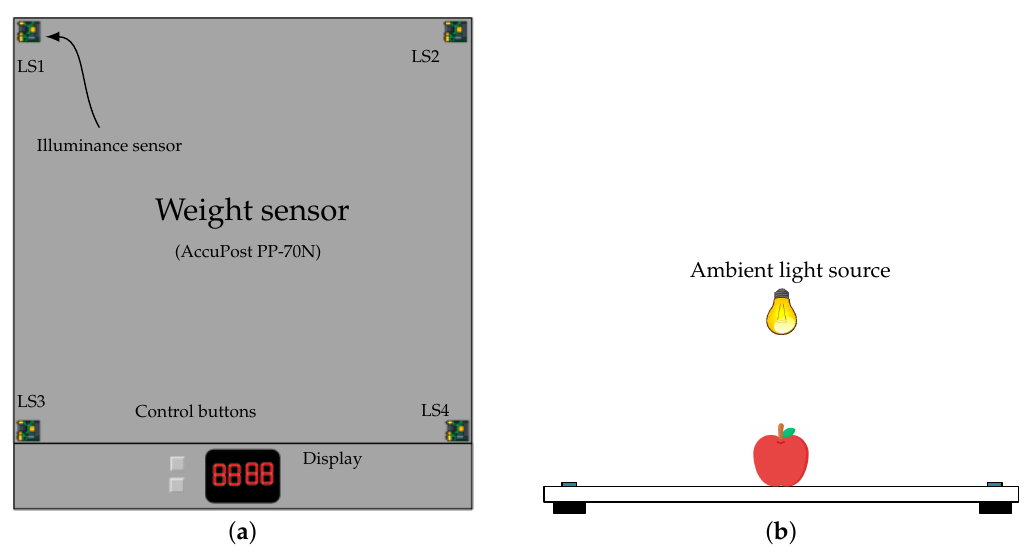
Figure 1. The detailed layout of: ( a ) Relative placement of weight scale, light source, illuminance sensor, and fruit or vegetable sample, and ( b ) Illustration of the light source w.r.t. fruit and illuminance